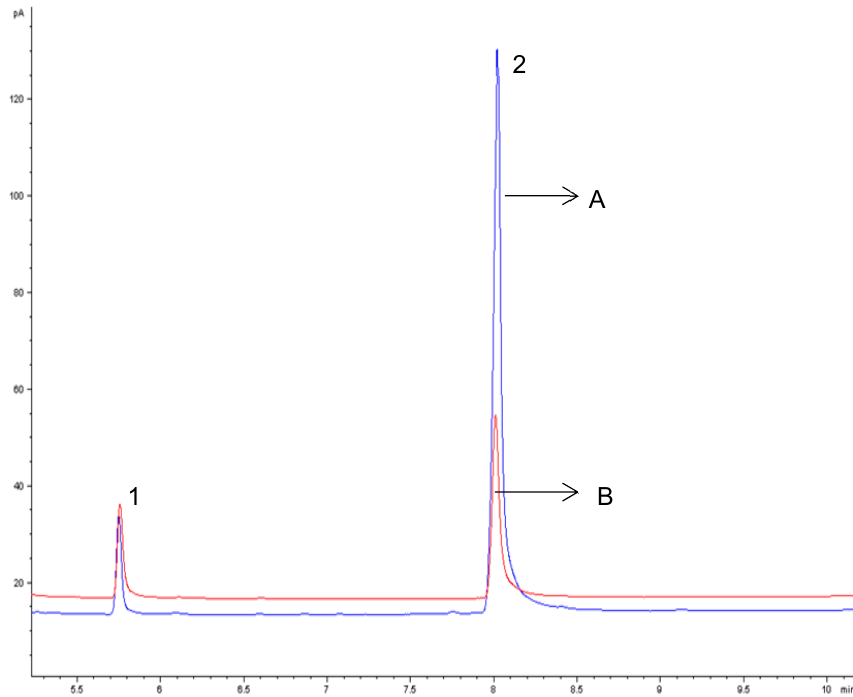
Figure 2. Gas chromatographic profiles of cholesterol in egg yolk from the control (A) and egg yolk treated with β -CD (B). Peak identification: 1 = cholestane, 2 = cholesterol.